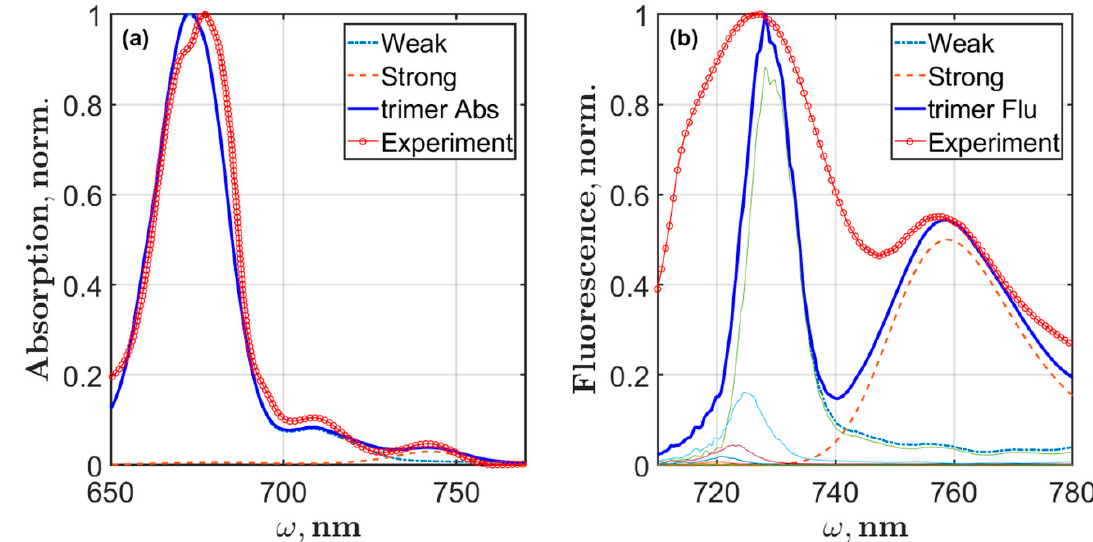
Figure 8. Results of Qy linear absorption ( a , trimer Abs) and steady-state fluorescence ( b , trimer Flu) modeling for the PSI trimer isolated from Arthrospira platensis . The excitonic part (Weak) of both spectra is calculated assuming weak electron-phonon coupling, whereas the F760 state contribution (Strong) requires the strong electron-phonon coupling approximation. The experimental cryogenic absorption and SMS fluorescence are shown (red). The thin colored lines are the intensities of exciton states.